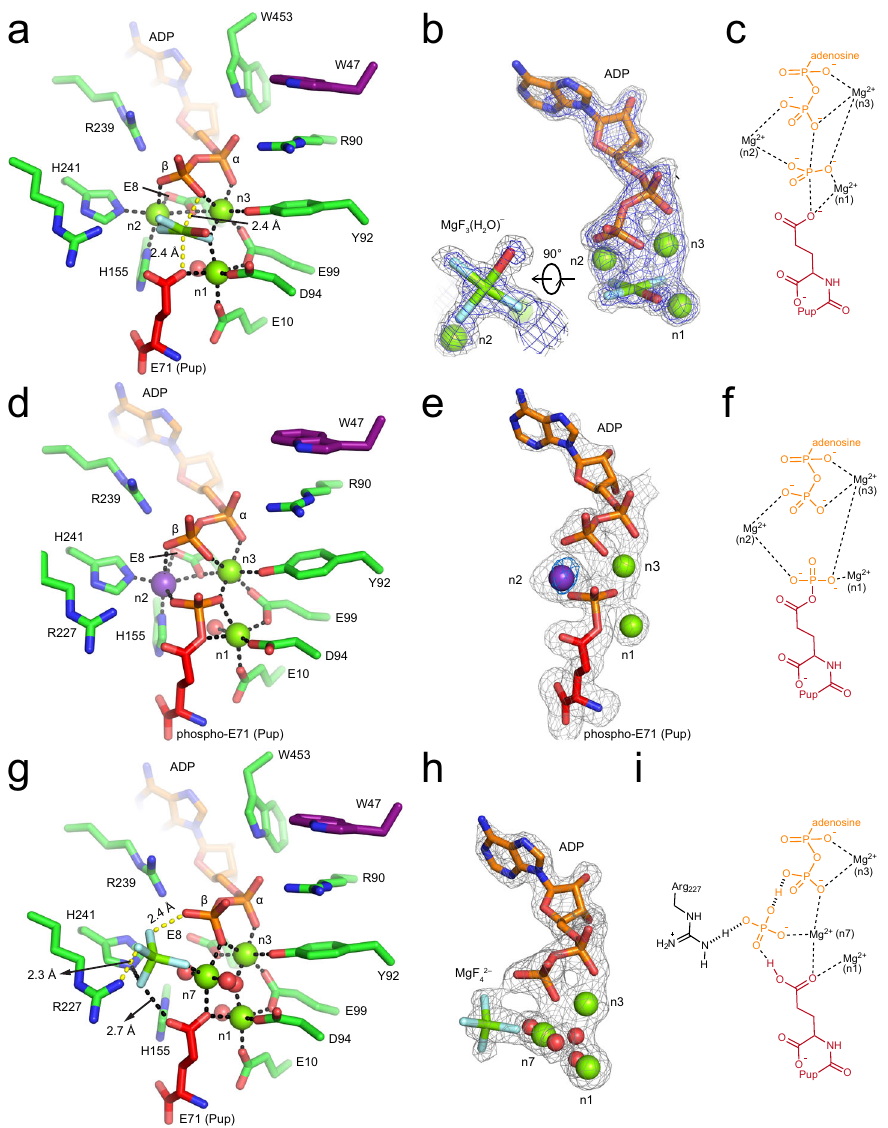
Fig. 5 Crystal structures of Dop-PupE complexes in distinct intermediate states of ATP hydrolysis generating the catalytic Pi in the active site. a - c , Crystal structure of the Dop-PupE-ADP-MgF 3 (H 2 O) − complex mimics the transition state of ATP hydrolysis. a Dop active site with bound ADP (orange), magnesium ions (green spheres), the C-terminal residue of Pup (red) and MgF 3 (H 2 O) − (green, cyan, and red). The color-coding of the Dop structure here is consistent with Fig. 1a. Polar interactions are indicated by black or yellow dashed lines. b The unbiased mFo-DFc Fourier map of ADP, magnesium ions, and MgF 3 (H 2 O) − at 4.0 σ (gray) or 5.7 σ (blue) contour level was calculated during molecular replacement using PDB 5LRT excluding ligands followed by three rounds of re fi nement without further model building. c Schematic representation of the proposed transition state of ATP hydrolysis in the Dop active site. d – f Crystal structure of Dop in complex with phosphorylated PupE Δ N43 . d Active site of Dop with bound ADP, phosphorylated PupE Δ N43 , magnesium and potassium ions (purple sphere). Interactions are presented as black dashed lines. e The simulated annealing polder map of ADP, magnesium ions, potassium ion and Pup C-terminal residue at 3.0 σ contour level was calculated using phenix.re fi ne with the coordinates of the input model randomly displaced by 0.5 Å. The blue density at 5 σ contour level around the potassium ion represents the anomalous signal calculated from a data set collected at 2 Å wavelength. f Proposed active site of Dop in complex with ADP, magnesium ions and phosphorylated Pup. g – i Crystal structure of Dop-PupE-ADP- MgF 4 2 − complex mimics the product state of ATP hydrolysis. g Dop active site with bound ADP, magnesium ions, MgF 4 2 − (green and cyan) and the C-terminal residue of Pup. Polar interactions are represented as black dashed lines except the low-barrier-hydrogen-bonds (yellow dashed lines). h The unbiased mFo-DFc Fourier map of ADP, magnesium ions, MgF 4 2 − and water molecules at 3.0 σ contour level was calculated the same way as for Fig. 5b. i Schematic representation of the proposed product state of ATP hydrolysis in the active site of Dop. Shared protons are bonded as hashed The phosphorylated Pup intermediate resulting from phos- ADP in the active site (Fig. 5d, e; Table 1). Presumably due to the phoryl transfer to the amide side-chain of the C-terminal residue high concentration of KH 2 PO 4 in the crystallization solution, a should only exist transiently in solution and be readily hydrolyzed potassium (K + ) ion instead of a Mg 2 + ion was identi fi ed at the after its formation 19 . However, when crystals of Dop-PupE n2 site, as indicated by the strong anomalous signal peak from complex were soaked with ATP for 19 h, we serendipitously data collected at around 2.0 Å wavelength (Fig. 5e), although produced Dop with a bound phosphorylated Pup fragment and under physiological conditions the n2 site is most likely occupied